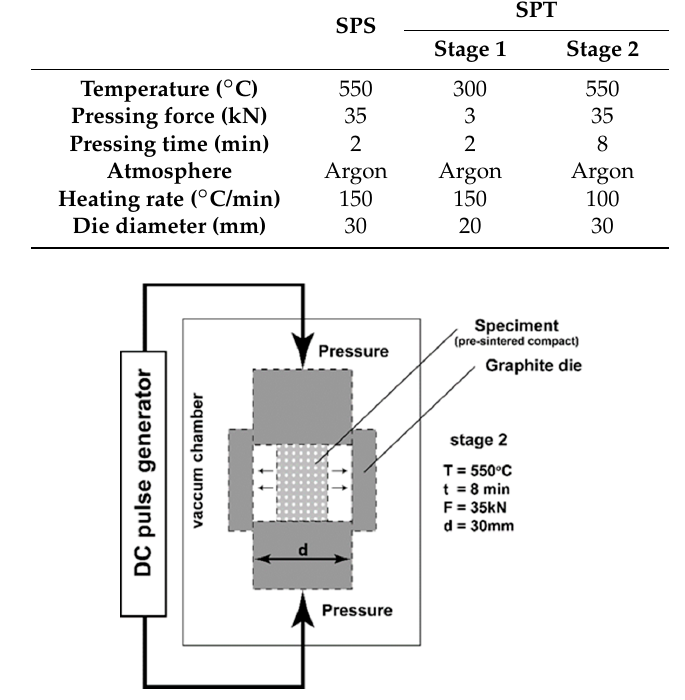
Figure 4. SPT processing scheme.